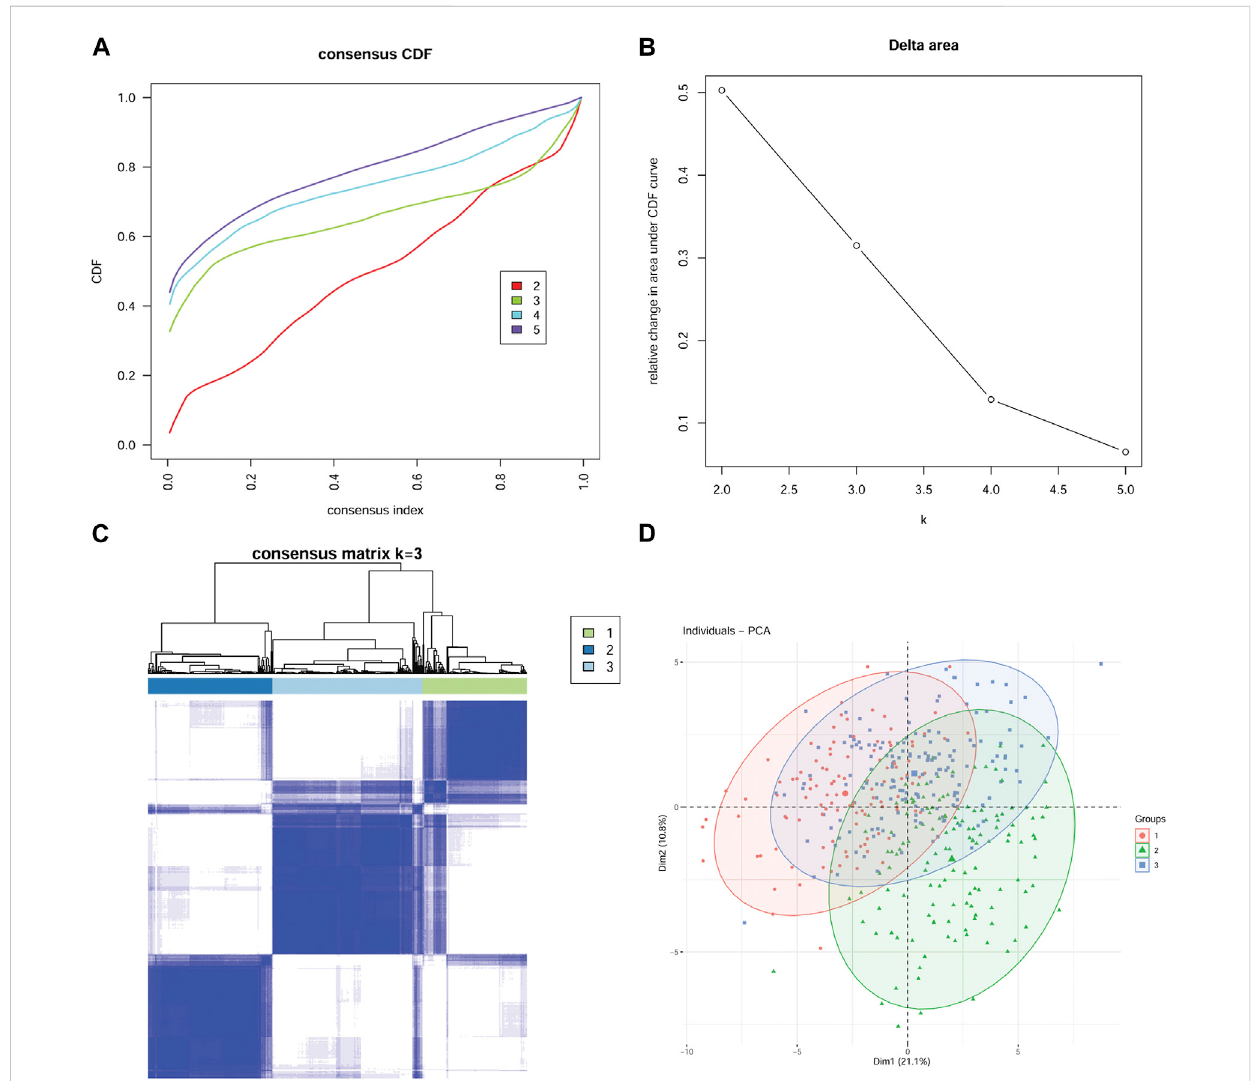
FIGURE 1 Establishment of a model based on expression pro fi les of 45 MMP-related genes Consensus CDF Plot (A) : A plot of the cumulative distribution function for different values of K, used to determine the value of K at which the CDF reaches its approximate maximum. Thus thesmaller the slope of the curve,thebettertheKvalue.DeltaAreaPlot (B) demonstratestherelativechangeintheareaundertheCDFcurvewhenKiscomparedtoK-1.Thesmaller therelativechange,thehigherthecon fi denceleveloftheclustering.Therefore,aftercombiningtheConsensusCDFPlotandDeltaAreaPlot,K=3is the optimal number of clusters. Consensus Matrix Plot (C) veri fi es the high clustering con fi dence at K = 3. The higher the clustering con fi dence and differentiation, the higher the degree of color aggregation of different matrices in the matrix plot and the more obvious the degree of discrepancy between matrices. (D) The principal component analysis (PCA) algorithm con fi rmed the validity and reasonableness of the classi fi